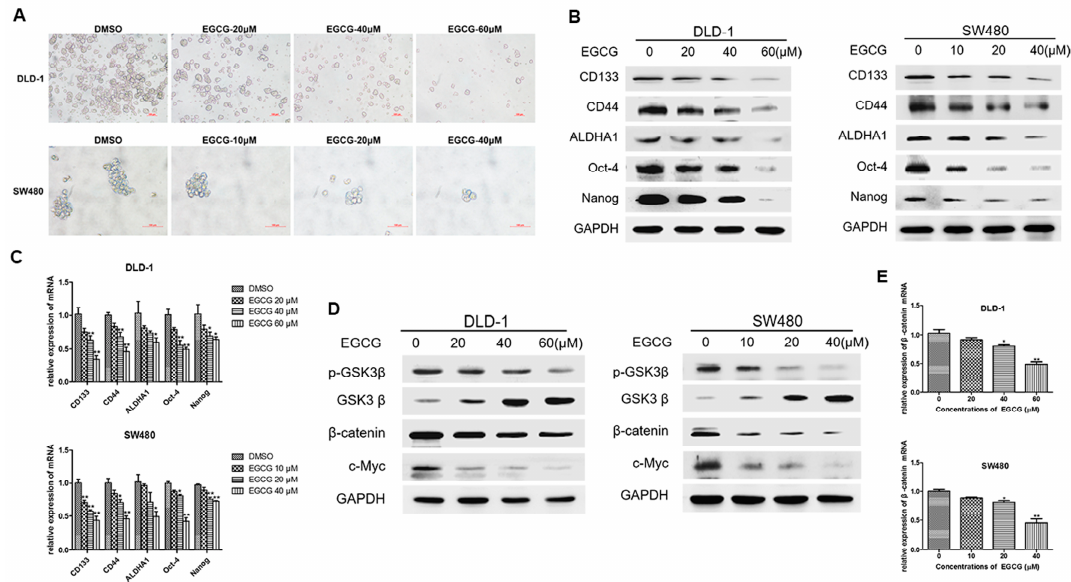
Figure 3. EGCG inhibited the CSCs properties and Wnt/ β -catenin pathway in colorectal CSCs. DLD-1 and SW480 cells were treated with different concentrations of EGCG for six days. ( A ) Images of DLD-1 and SW480 spheroids; ( B ) The protein levels of colorectal CSC markers, including CD133, CD44, ALDHA1, Nanog, and Oct4, were measured by Western blotting analysis; ( C ) The corresponding mRNA levels were measured by Quantitative real-time PCR; ( D ) The protein levels of Wnt/ β -catenin pathway (p-GSK3 β , GSK3 β , β -catenin, and c-Myc) were determined by Western blot analysis; ( E ) Quantitative real-time PCR analysis for the mRNA levels of β -catenin. Data are expressed as mean ± SD of three independent experiments. * p < 0.05, ** p < 0.01 compared with control group.